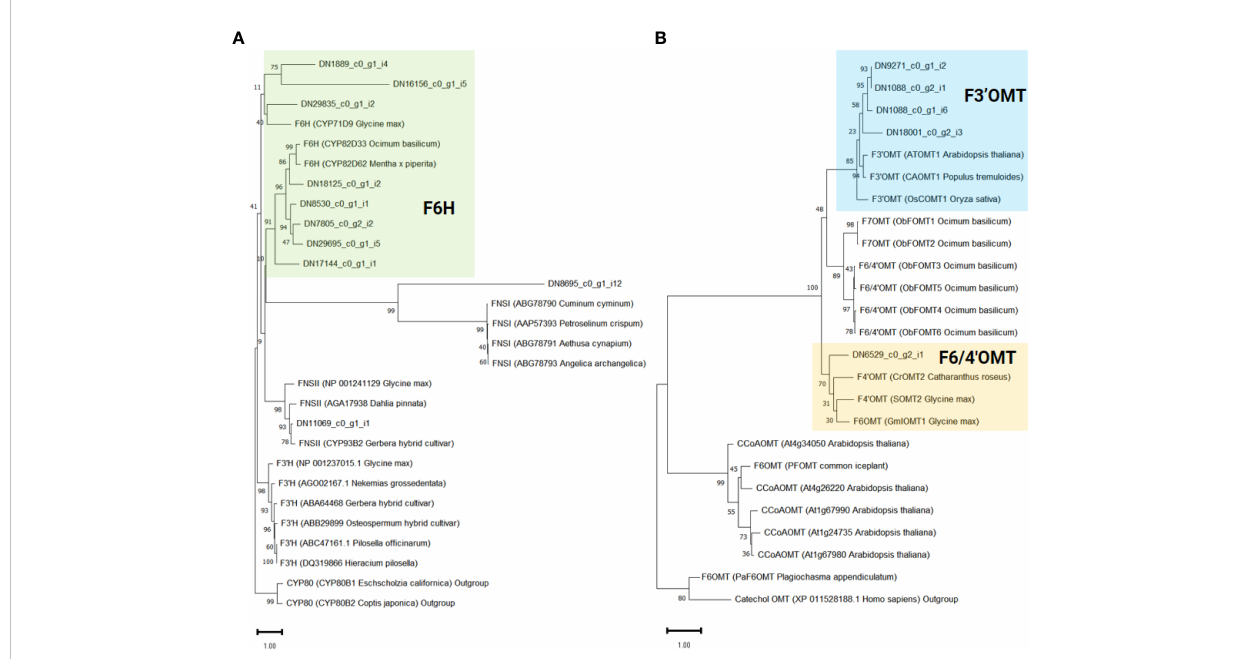
FIGURE 5 Phylogenetic analysis of fl avonoid-related genes identi fi ed in ‘ cluster 9 ’ . The support values were obtained after 1,000 tests and indicated near the nodes. Protein sequences of previously known (A) Cytochrome P450 and 2-oxoglutarate-dependent dioxygenase and (B) O -methyltransferase genes were obtained from the NCBI database. The protein ID and the derived species information are enclosed in